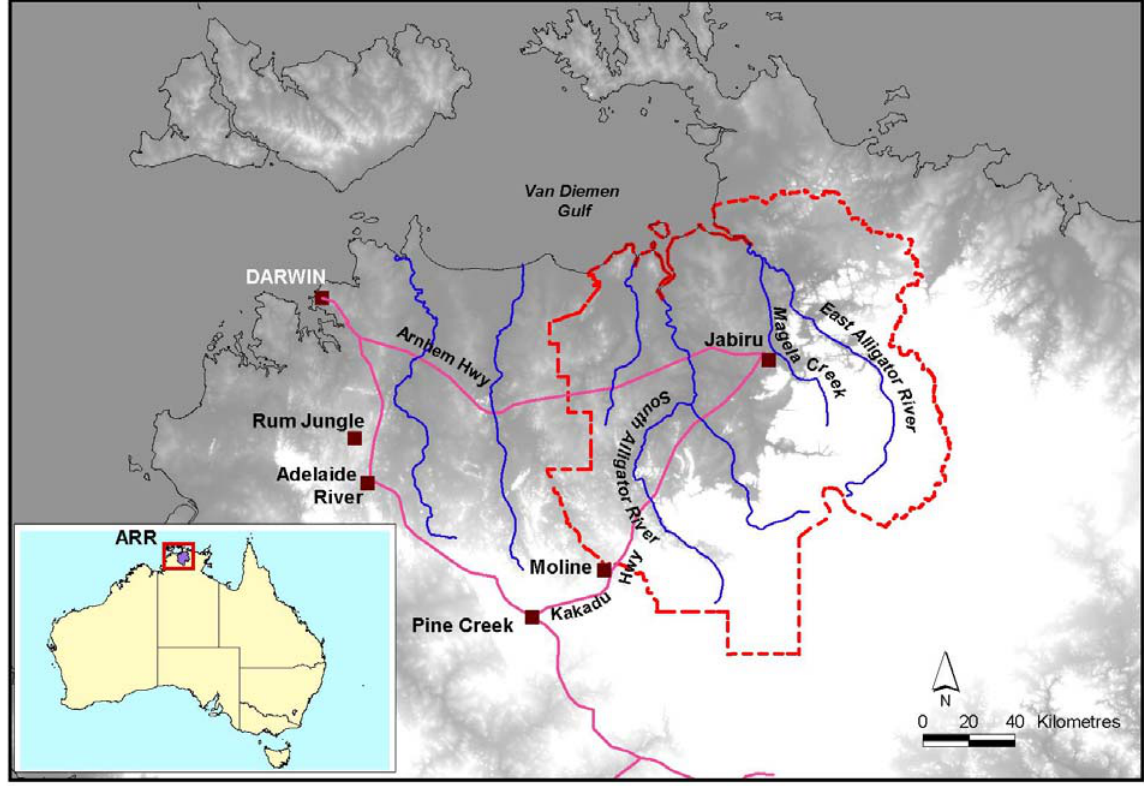
FIGURE 1. Maps of Australia and of the Top End, showing the locations of the Alligator Rivers Region, and the location of the Rum Jungle mine and Moline mill sites.